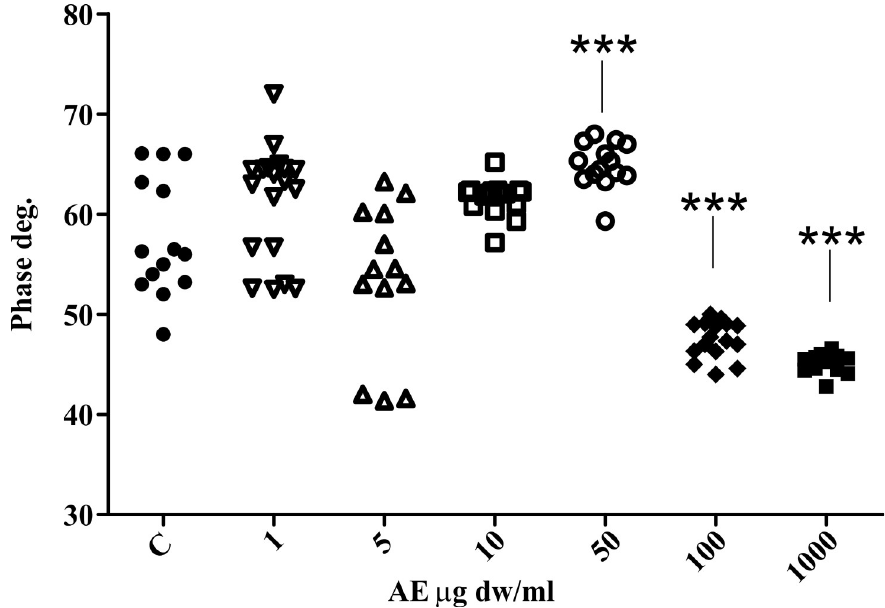
Fig 10. Scatter plots of phase data obtained by phase AFM imaging. Dunnett’s multiple comparison test was employed to verify the statistical differences among the samples and only comparison with control are reported. ��� P « 0.01.